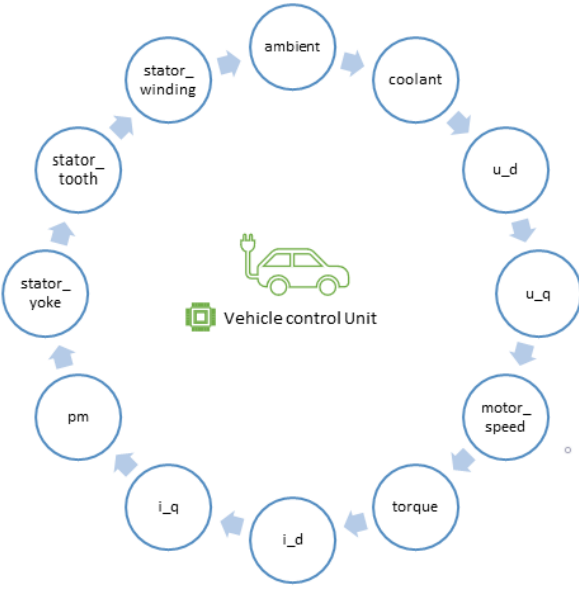
Figure 7. Components of vehicle control unit